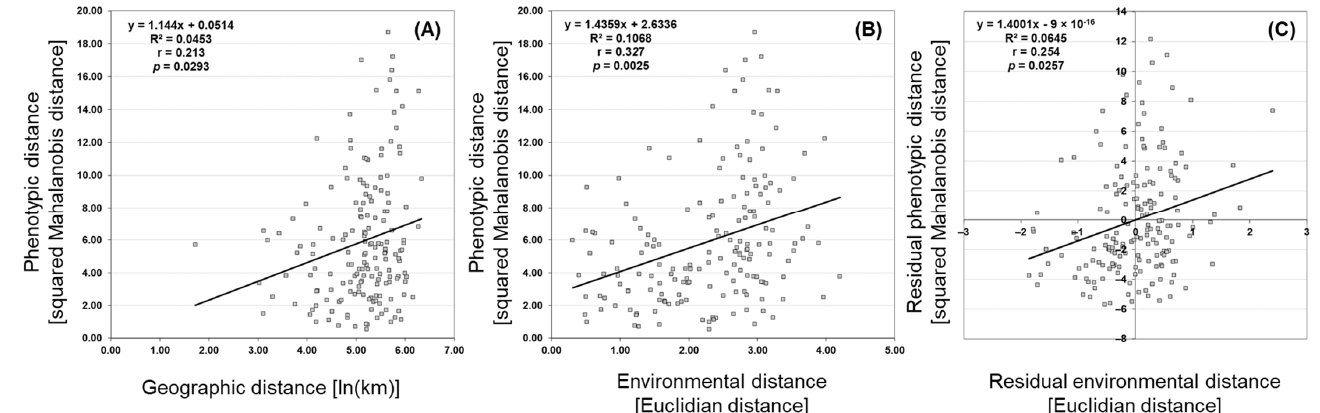
Figure 5. Isolation by distance (IBD) and isolation by environmental distance (IBE) in European wild pear populations. Scatter plots of simple and partial Mantel’s tests showing the relationships between ( A ) geographic and phenotypic distances (r = 0.213, p = 0.0293, R 2 = 0.0453); ( B ) environmental and phenotypic distances (r = 0.327, p = 0.0025, R 2 = 0.1068); and ( C ) residual environmental and phenotypic distances (r = 0.254, p = 0.0257, R 2 = 0.0645) by taking into account the geographic distances among 19 European wild pear populations.